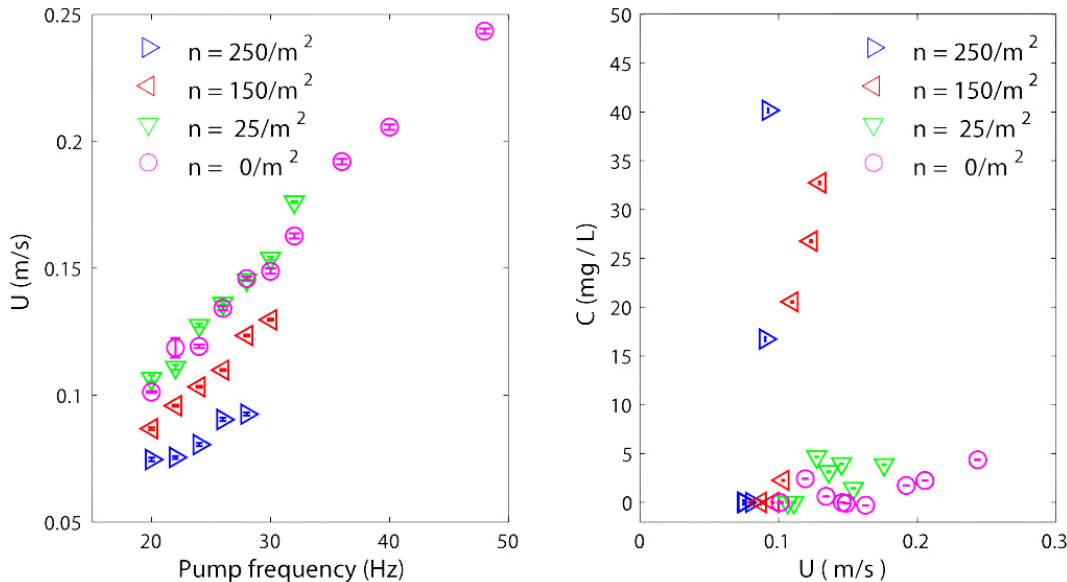
Figure 5. Left: mean longitudinal x velocities as a function of the pump frequency. Right: mean suspended sediment concentrations recorded at each velocity for all densities. Velocities measured at the center of the array x c = 3m, at z = 0 . 05m above the bed. Vertical error bars for the 95% CI. Notice the range of velocities studied decreased for the denser cases to avoid disruptions in the bed.